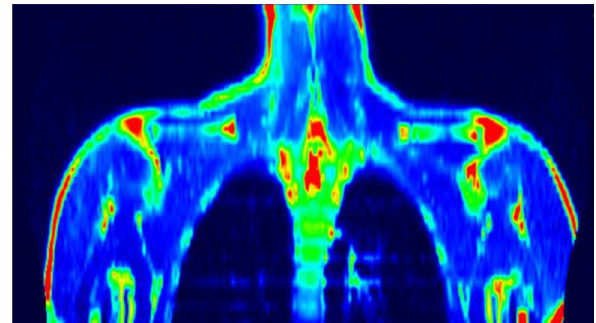
Figure 2. A typical PET scan of a BAT-negative subject.